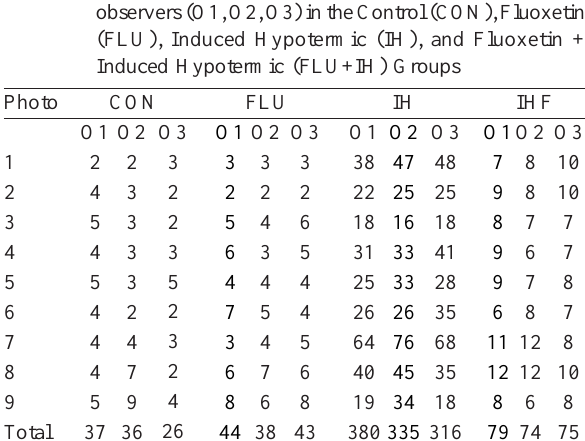
Table 2. Values of mitochondrial profiles with crystalysis for nine photomicrographs analysed by three independent observers (O1, O2, O3) in the Control (CON), Fluoxetin (FLU), Induced Hypotermic (IH), and Fluoxetin